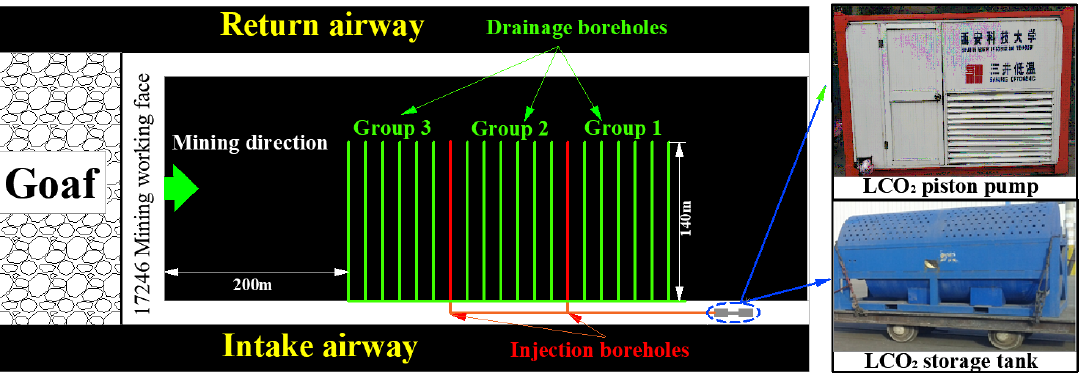
Figure 12. Layout schematic of boreholes in the 17,246 Intake airway.